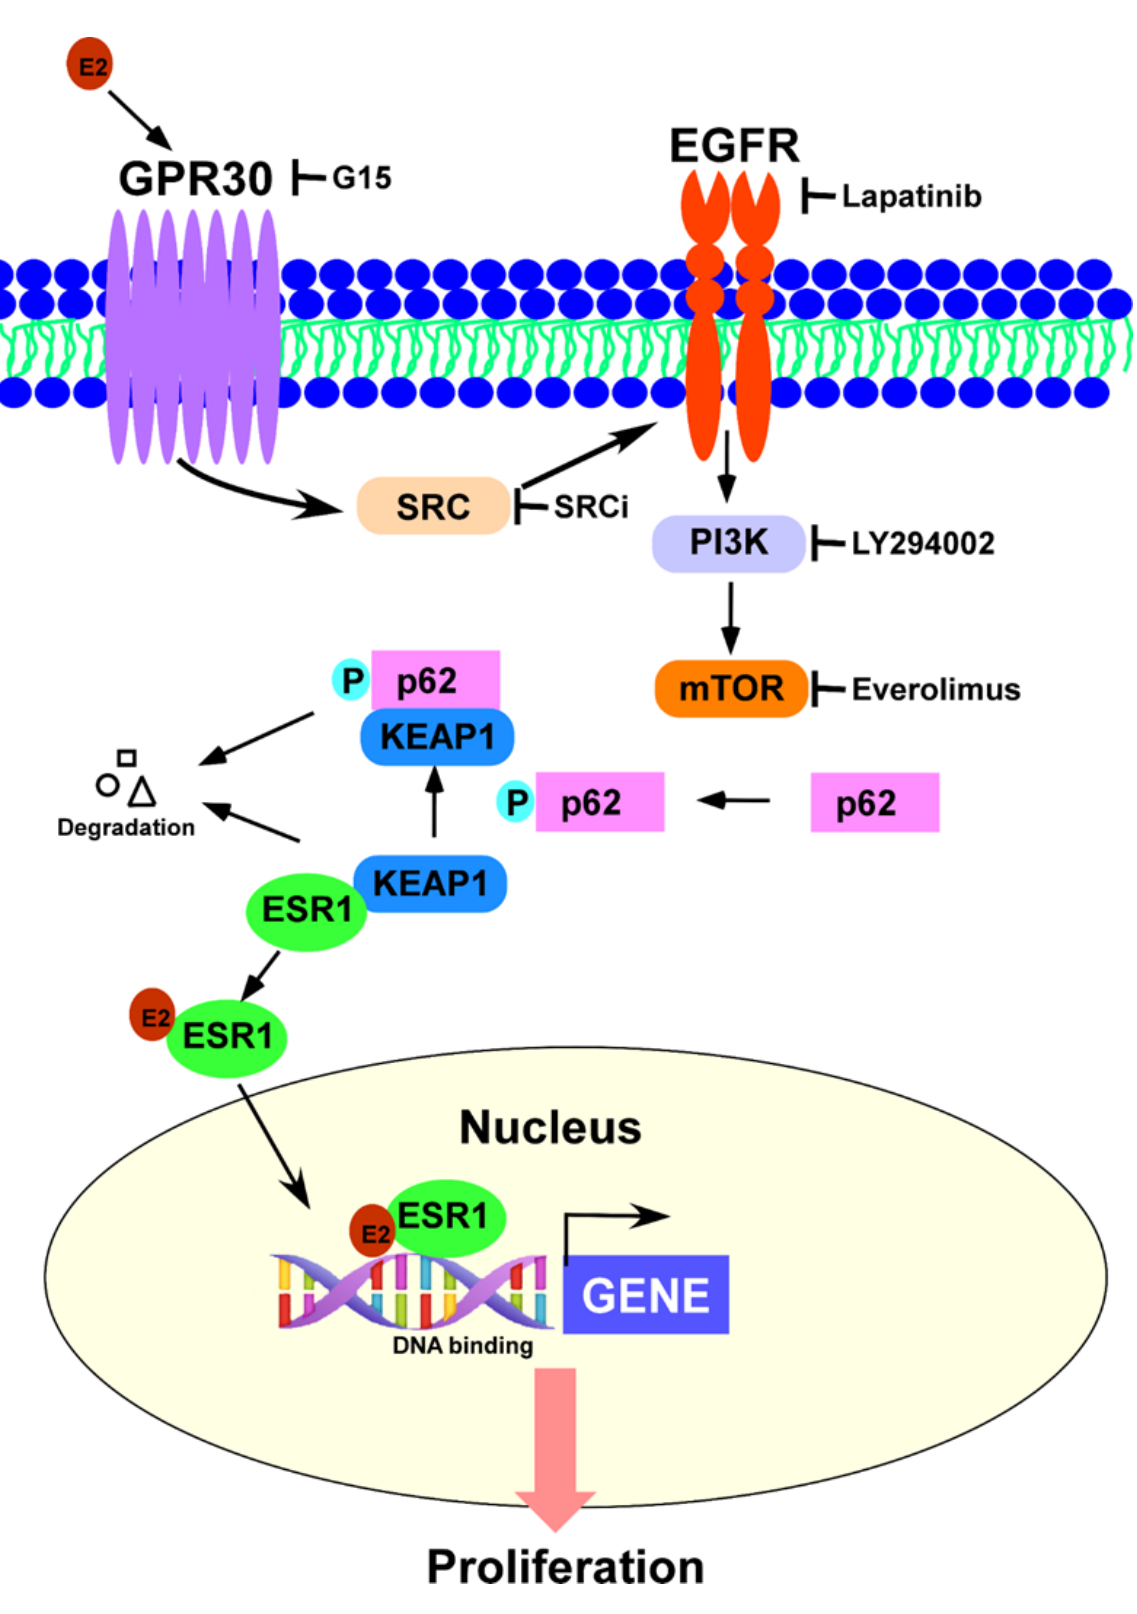
Figure 6. GPR30 activation by 17β -estradiol elicits the SRC/EGFR/PI3K/Akt/mTOR signaling pathway and promotes p62 phosphorylation—which in turn induces ESR1 protein expression through estrogen receptor α (ESR1) detachment from a complex formed with KEAP1. This complex interplay provides a link between the rapid-signal effects of estrogens (mediated by GRP30) and their canonical genomic effects (mediated by